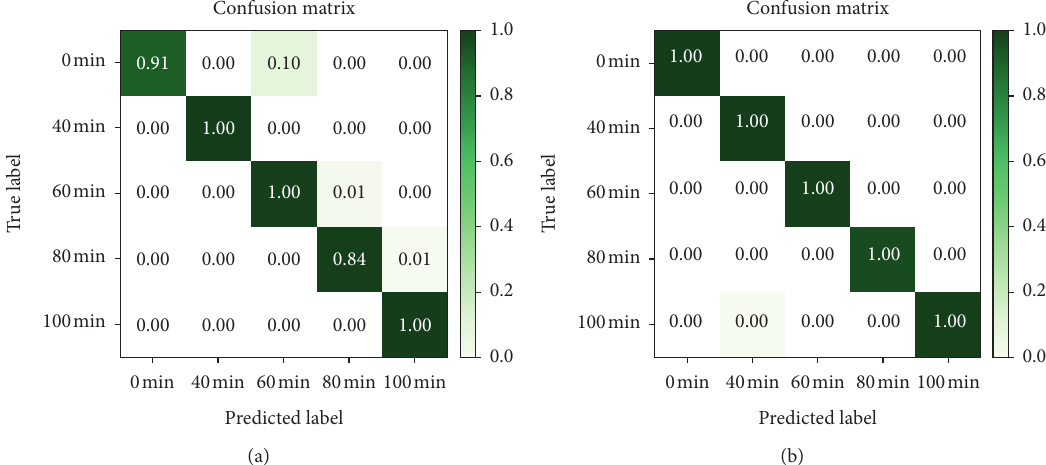
Figure 14: Confusion matrixes of classification for the dataset of the 10mm tool: (a) lowest accuracy � 97.8%; (b) highest accuracy �